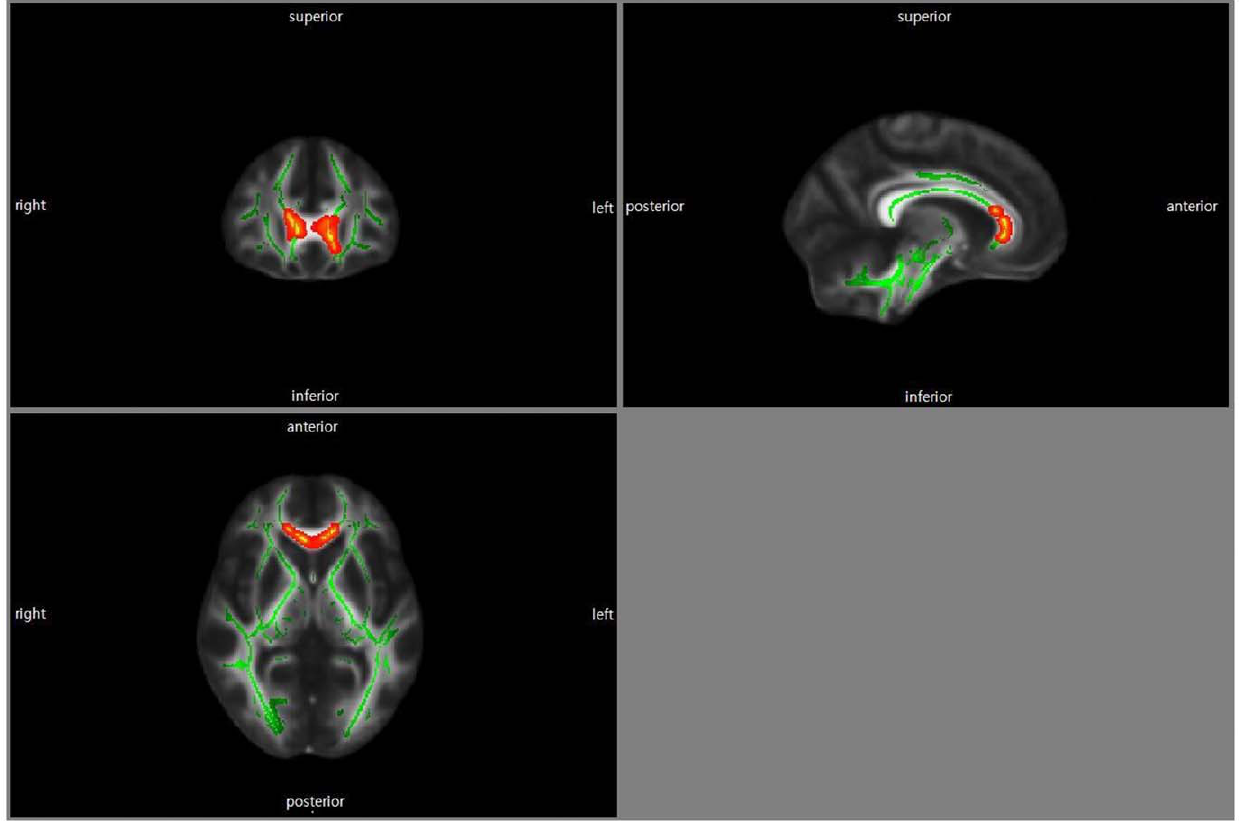
Figure 1. Comparison of the nonapathy group versus the apathy group. Statistical maps corrected for age, education, sex, and TIV showing lower FA values in AD patients with apathy relative to AD patients without apathy. The results were color-coded by p corrected , 0.05. Red color denotes regions of declined FA values. AD, Alzheimer’s disease; CDR, Clinical Dementia Rating Scale; FA, Fractional Anisotropy; TIV, Total Intracranial Volume. doi:10.1371/journal.pone.0053493.g001 PLOS ONE |